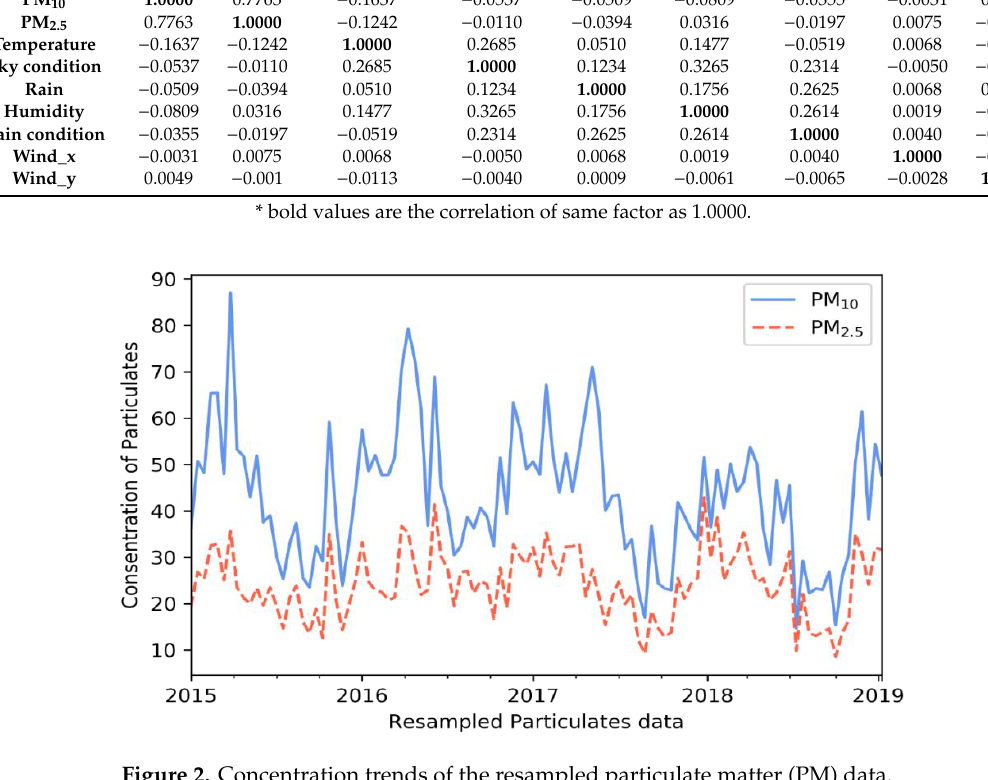
Table 3. Training data and model parameters.